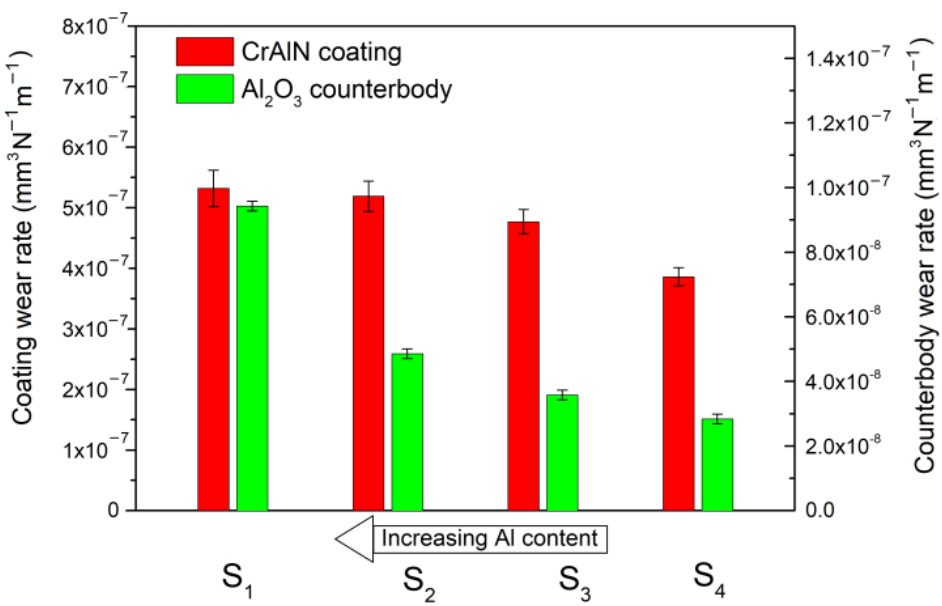
Figure 9. Wear rate of (Cr 1−x Al x )N coating and counter body for (Cr 1−x Al x )N/Al 2 O 3 sliding pair. SEM images of wear scars in Figure 10 depict the surface of the ceramic ball in the (Cr 1−x Al x )N/Al 2 O 3 sliding pair. One can see that the wear scar diameter on the ceramic ball is four or five times smaller than on the steel ball. The highest wear is observed for sub- strate S1, when the coating hardness is comparable to that of the counter body. The lower the Al content in the (Cr 1−x Al x )N coating, the lower the substrate hardness and wear scar diameter on the counter body surface.